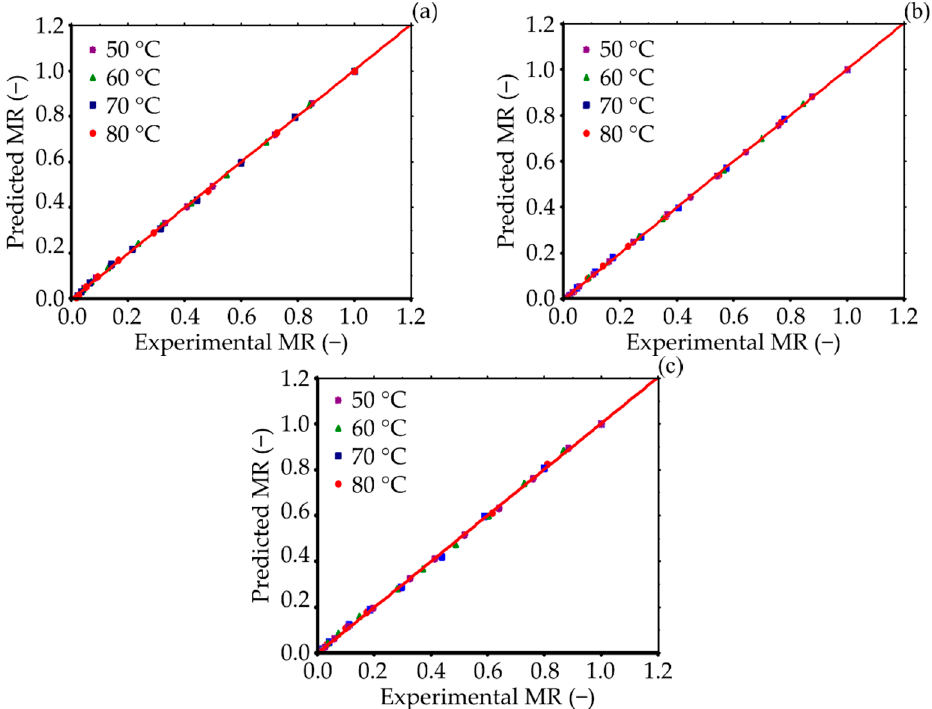
Figure 2. Relationship between the values predicted by the Page model and the experimental water content ratio values in the drying of germinated faba bean seeds at temperatures of 50, 60, 70 and 80 °C: ( a ) OVP; ( b ) RS; and ( c ) B. Table 3. Parameters of the Page model adjusted to experimental data of drying kinetics of germinated seeds of faba bean varieties, at temperatures of 50, 60, 70 and 80 ◦